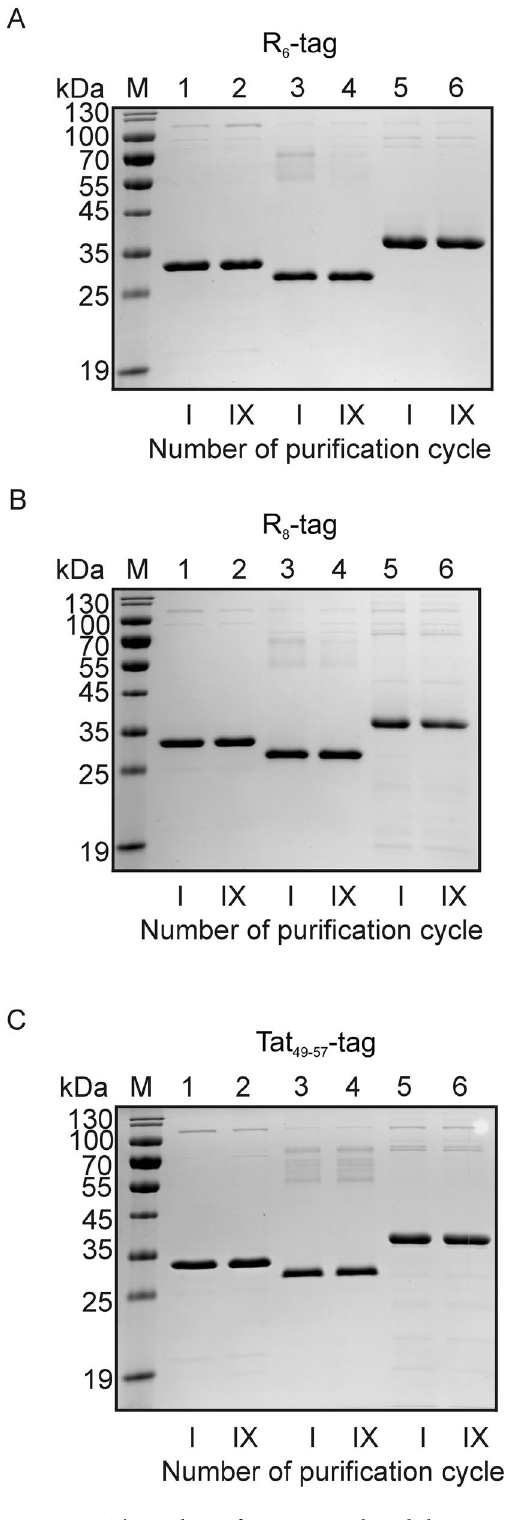
Figure 10. The analysis of AR aptamer-based chromatography reproducibility. 5 ′ -biotinylated AR aptamer bound to streptavidin-agarose resin was incubated with E. coli total protein extracts containing recombinant proteins. After washing, the bound protein was eluted using buffer supplemented with an appropriate GuHCl concentration. ( A ) R 6 , ( B ) R 8 and ( C ) Tat 49–57 tagged recombinant protein. Lanes: 1 and 2) GFP-tag, 3 and 4) tag-GST, 5 and 6) tag-PCNA. The purification of the tested protein was repeated nine times using the same resin. Next, 4 μ g of protein sample eluted after the first and ninth purification cycle was denatured and separated on 12% SDS-PAGE followed by Coomassie staining. This is one of three independent experiments which is